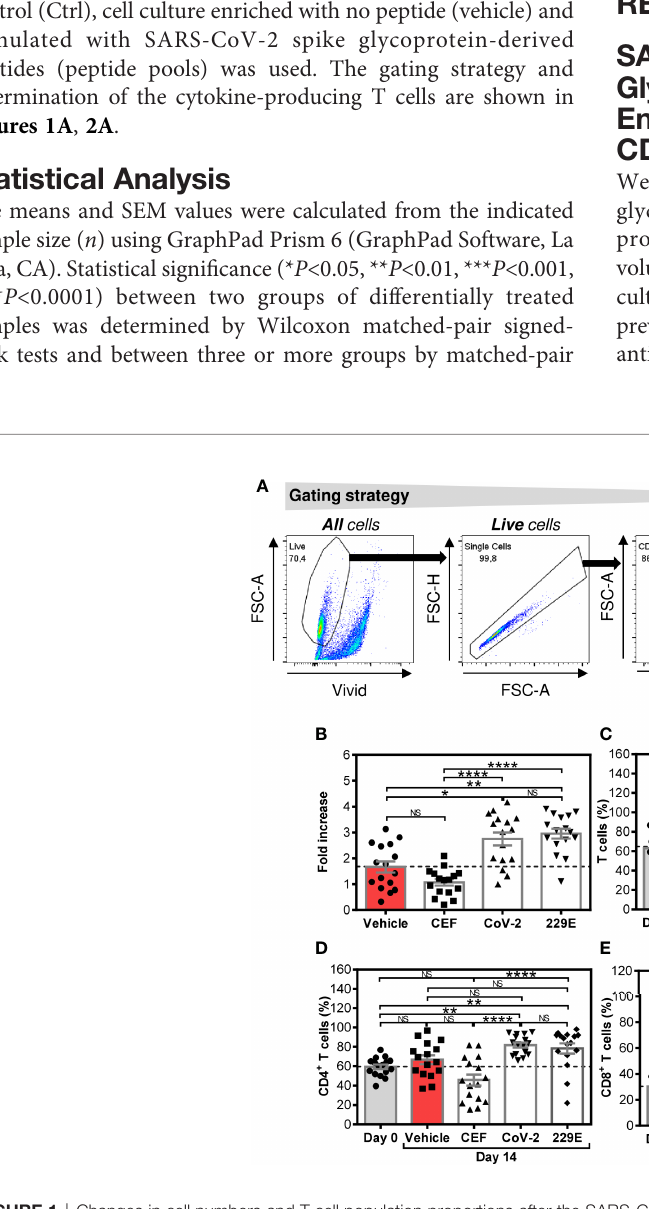
FIGURE 1 | Changes in cell numbers and T cell population proportions after the SARS-CoV-2- and HCoV-229E-spike glycoprotein peptide pool-mediated culture enrichment (A) The gating strategy used to analyze fl ow cytometry data. (B) Cell number fold increase in cultures enriched with no peptides (Vehicle) or with CEF (CEF), SARS-CoV-2 (CoV-2), or HCoV-229E (229E) peptide pools. (C) Proportion of T cells (CD3 + cells) before (Day0) and after 14-day enrichment with the peptide pools described in (B) . (D) Proportion of CD4 + T cell population (CD3 + CD4 + cells) before (Day0) and after 14-day enrichment with the peptide pools described in (B) . (E) Proportion of CD8 + T cell population (CD3 + CD8 + cells) before (Day0) and after 14-day enrichment with the peptide pools described in (B) . In (B – E) , bars represent mean of values and SEM determined in each group and signi fi cances of differences among the groups are indicated (* P <0.05, ** P <0.01, *** P <0.001, **** P <0.0001, n = 16 donors (6 healthy male donors and 10 HR metastatic PCa patients), 1-way ANOVA with the Dunn ’ s posttest). P >0.05 were considered nonsigni fi cant